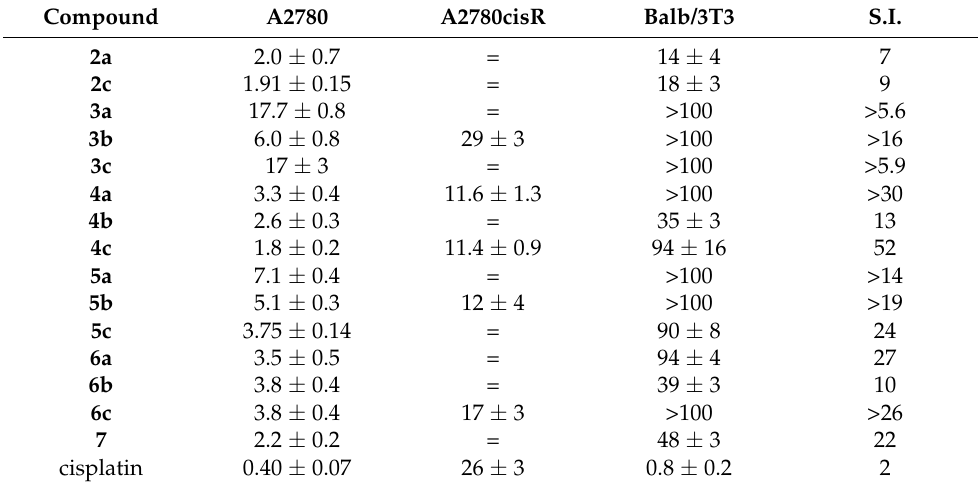
Table 4. IC 50 values ( µ M) determined for diiron complexes and cisplatin on human ovarian carcinoma (A2780), human ovarian carcinoma cisplatin-resistant (A2780cisR) and murine embryonic fibroblast (Balb/3T3 clone A31) cell lines after 72 h exposure. Values are given as mean ± standard deviation. Selectivity index (S.I.) calculated as the ratio between IC 50 for Balb/3T3 and IC 50 for A2780. Compound A2780 A2780cisR Balb/3T3 S.I. 2a 2.0 ±